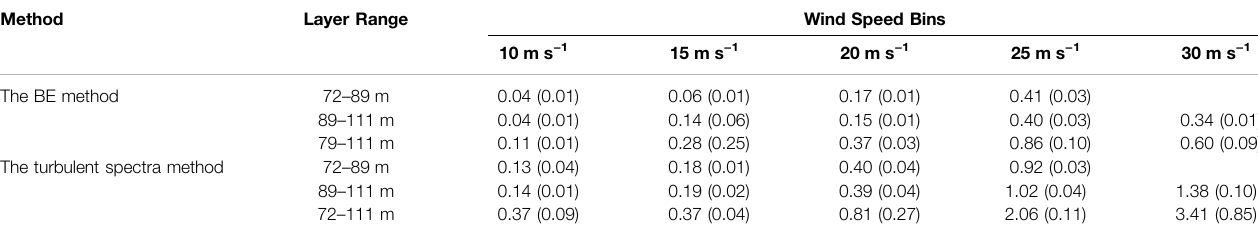
TABLE 1 | The bin-averaged integrated DH values (W m − 2 ) estimated with the turbulent spectra method and the BE method, with the standard deviations included in parentheses. Method Layer